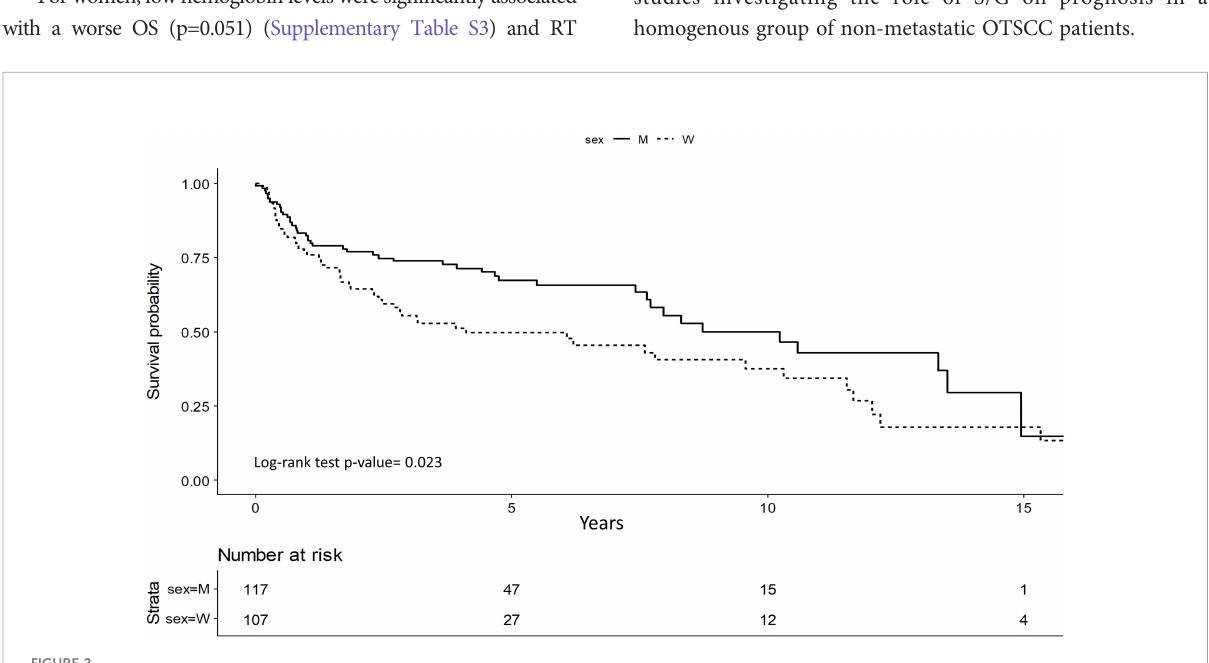
FIGURE 2 Disease Free Survival (DFS): women vs men in stage I and